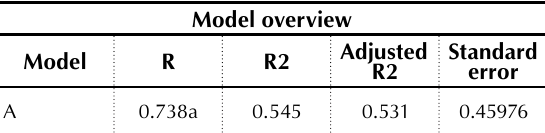
Table 9. Overview of model A